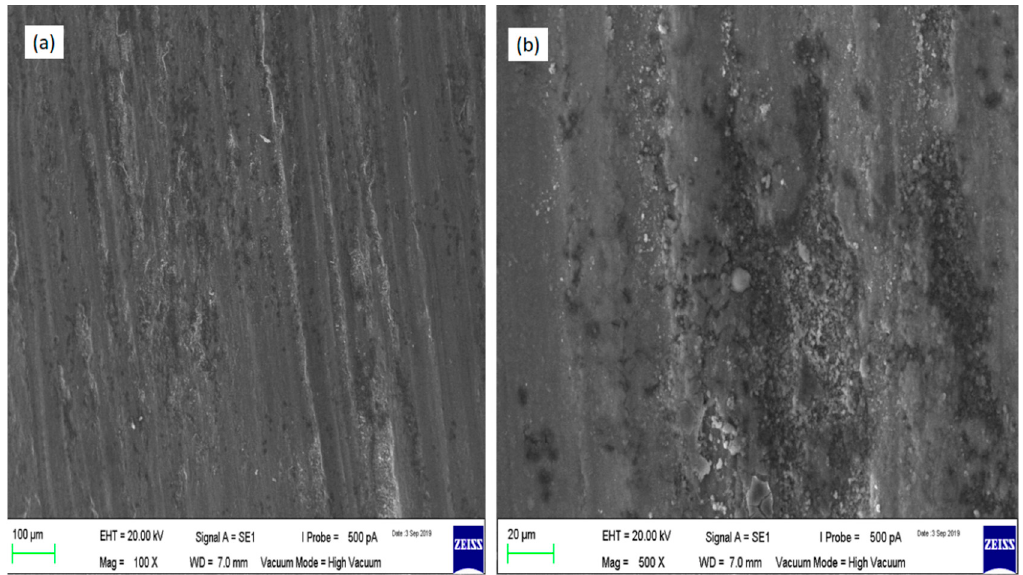
Figure 10. SEM mapping analysis on the wear tracks of Run 20 AA7075-SiC / fly ash surface composite.